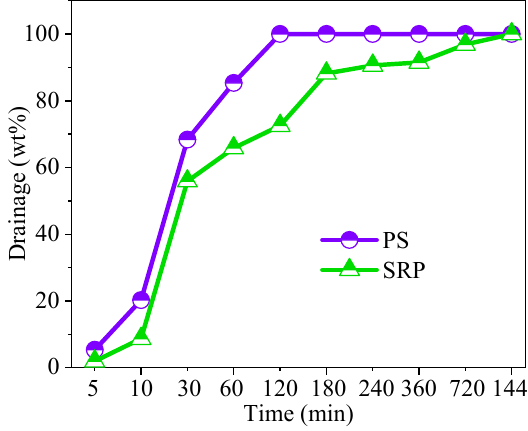
Figure 6. Drainage of foams.